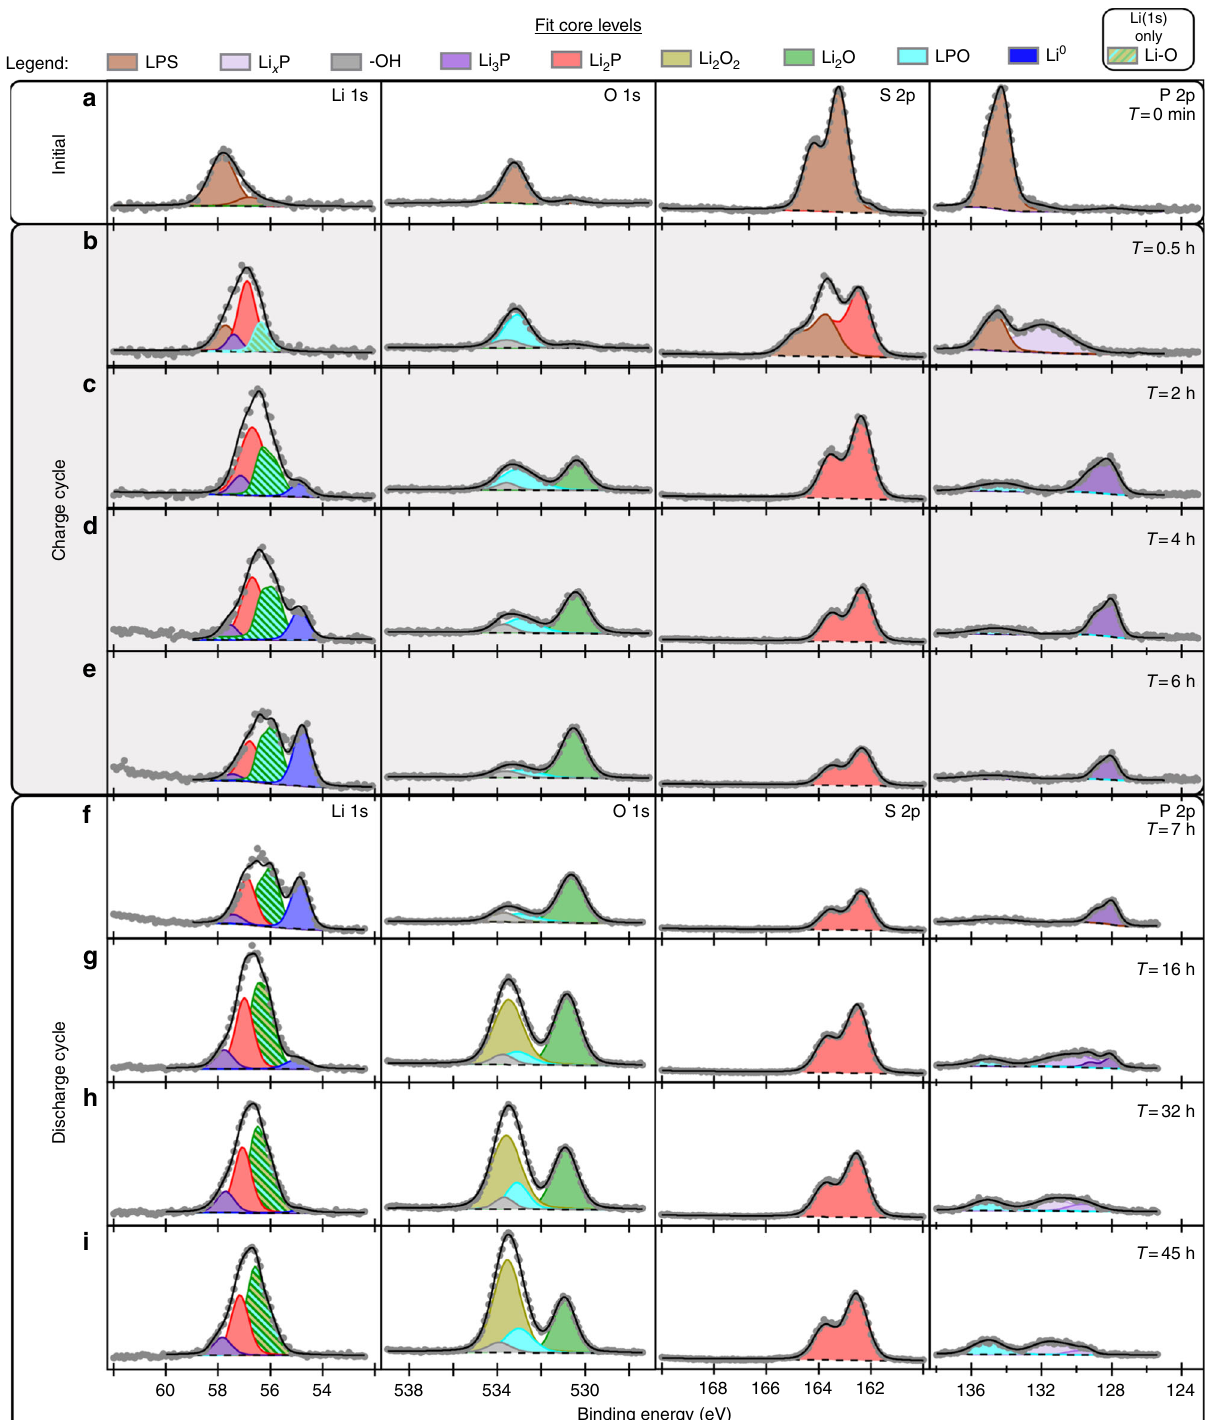
Fig. 3 opXPS spectral decomposition of Li/LPS SEI for the fi rst charge-discharge cycle. XPS spectra showing curve- fi tting results for: a spectra from the sputter-cleaned LPS surface; b – e four sets of spectra during the charging step; and f – i four sets of spectra during the discharge half cycle. Due to existence of multiple O-containing species that can be fi t in the Li 1s spectra, a single peak representing the summation of O-containing Li 1s components is shown with crosshatched colors of the various contributing components. For both the S 2p and P 2p core levels the 2p 3/2 and 2p 1/2 peaks have been combined into single lineshapes for simplicity. However, it should be noted that the appropriate intensity-ratio and BE separation constraints were applied during curve fi tting of these